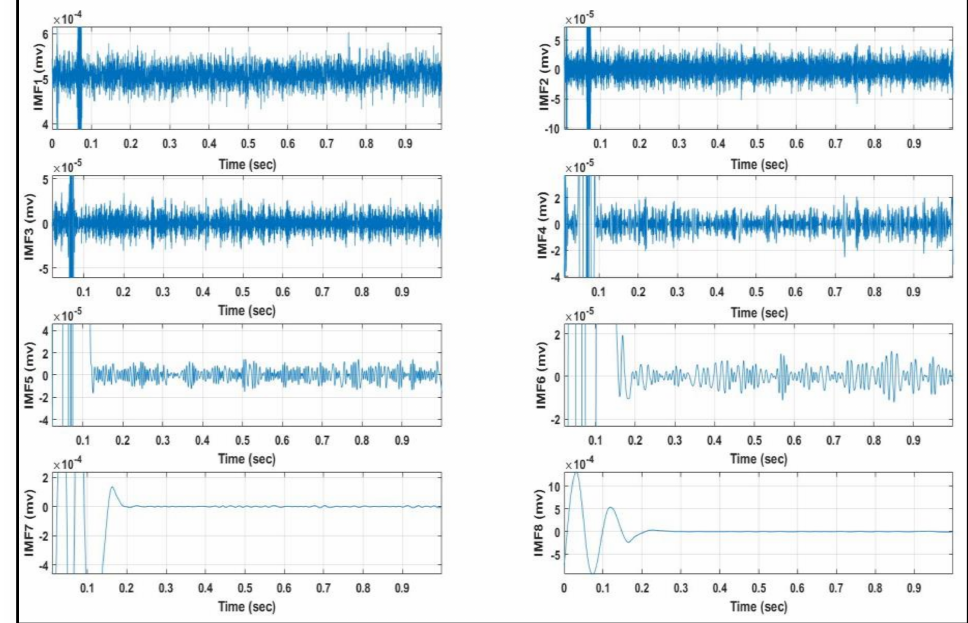
Figure 10. IMFs with leak signal response with pressure condition of 2 bar.